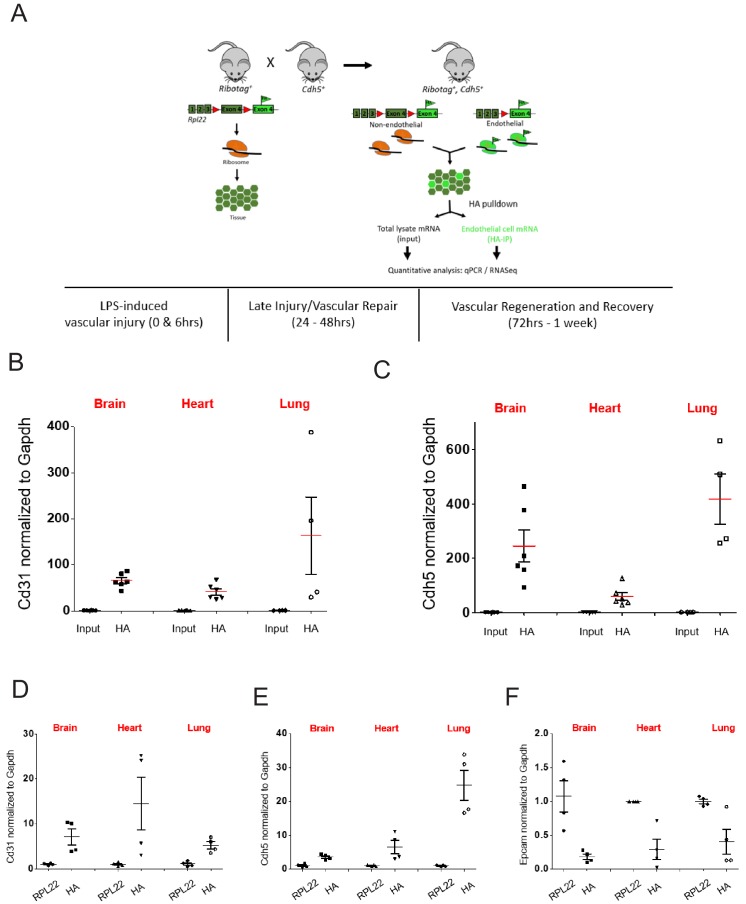
RiboTag Isolation of endothelial mRNA.(A) Schematic of RiboTag method for isolating the endothelial-specific translatome at various time points during LPS induced inflammatory injury, repair, and regeneration. (B–D) Mice brain, lung, and heart RiboTagEC samples were homogenized with ice-cold homogenization buffer. mRNA from total lysate input and IP with HA antibody were used for RT-qPCR to compare (A) CD31, (B) Cdh5 (VE-cadherin). (D–F) RiboTagEC mice brain, lung, and heart samples were homogenized with ice-cold homogenization buffer. Total ribosome associated mRNA (IP with anti-RPL22) and endothelial specific ribosome associated mRNA (IP with anti-HA) were used for RT-qPCR to compare (D) Cd31 and (E) Cdh5 (VE-cadherin) (F) Epcam mRNA levels.